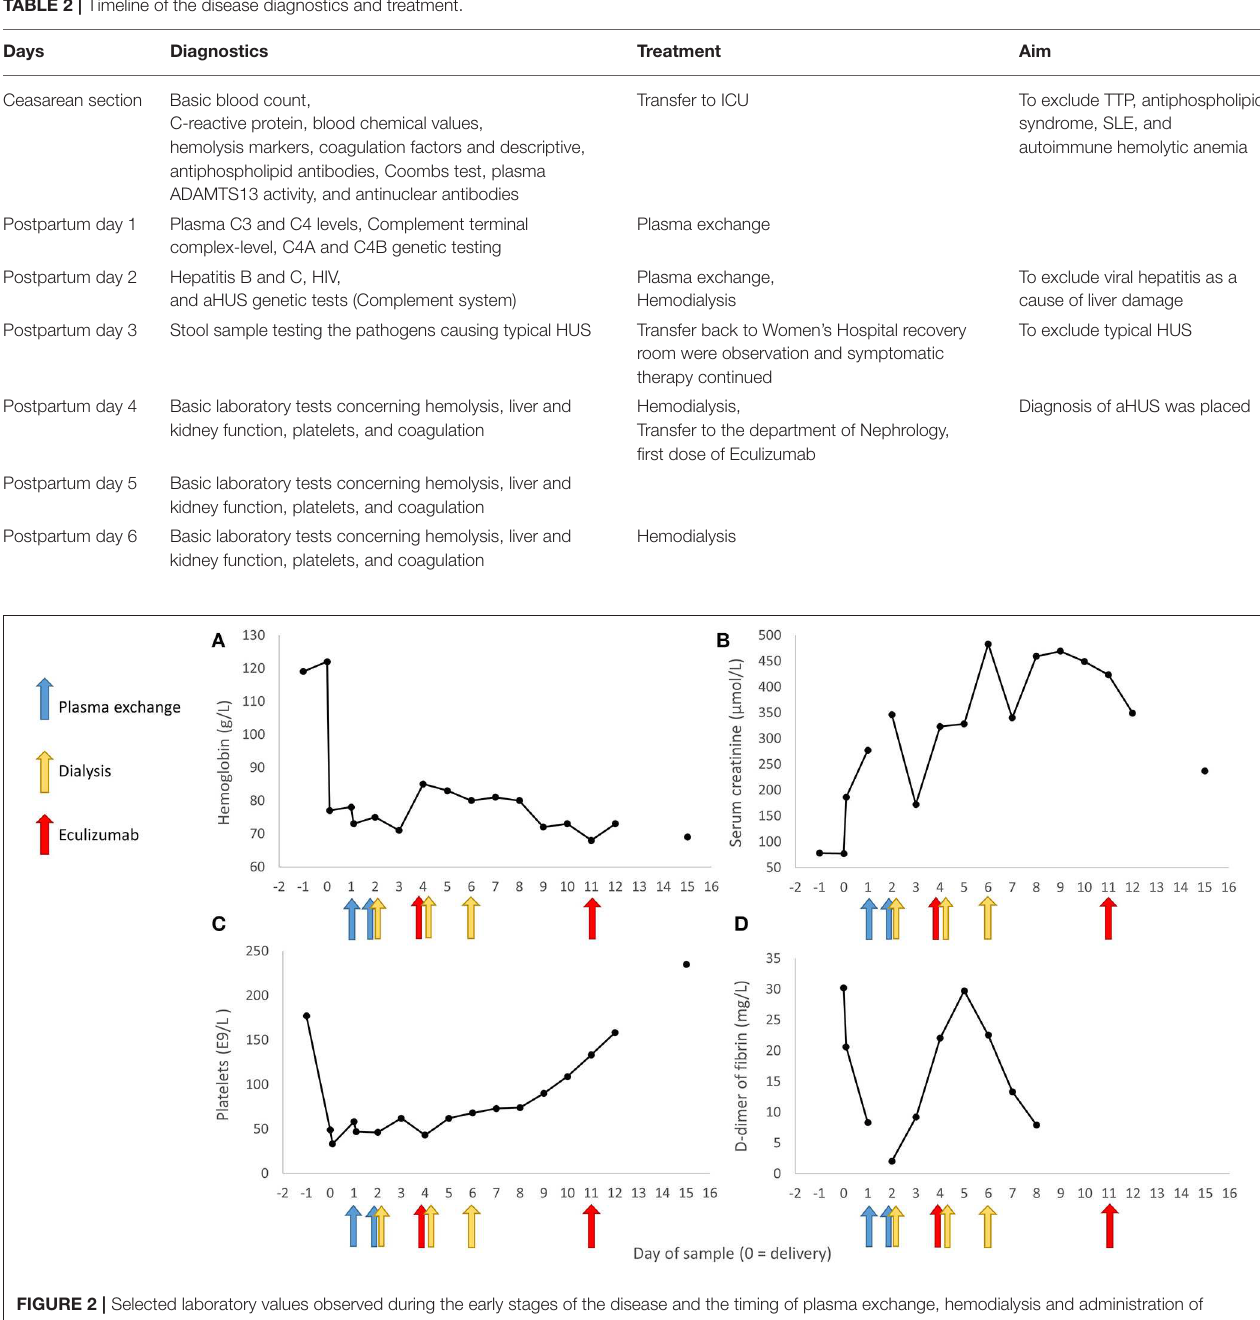
FIGURE 2 | Selected laboratory values observed during the early stages of the disease and the timing of plasma exchange, hemodialysis and administration of eculizumab. In panel (A) is represented the development of blood hemoglobin measurements, in panel (B) the serum creatinine level, in panel (C) the number of platelets, and in panel (D) D-dimer of fibrin values across the 17 day follow-up